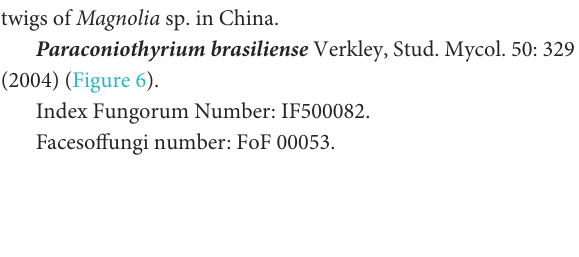
new collection as a new host record of P . archidendri from dead twigs of Magnolia sp. in China.